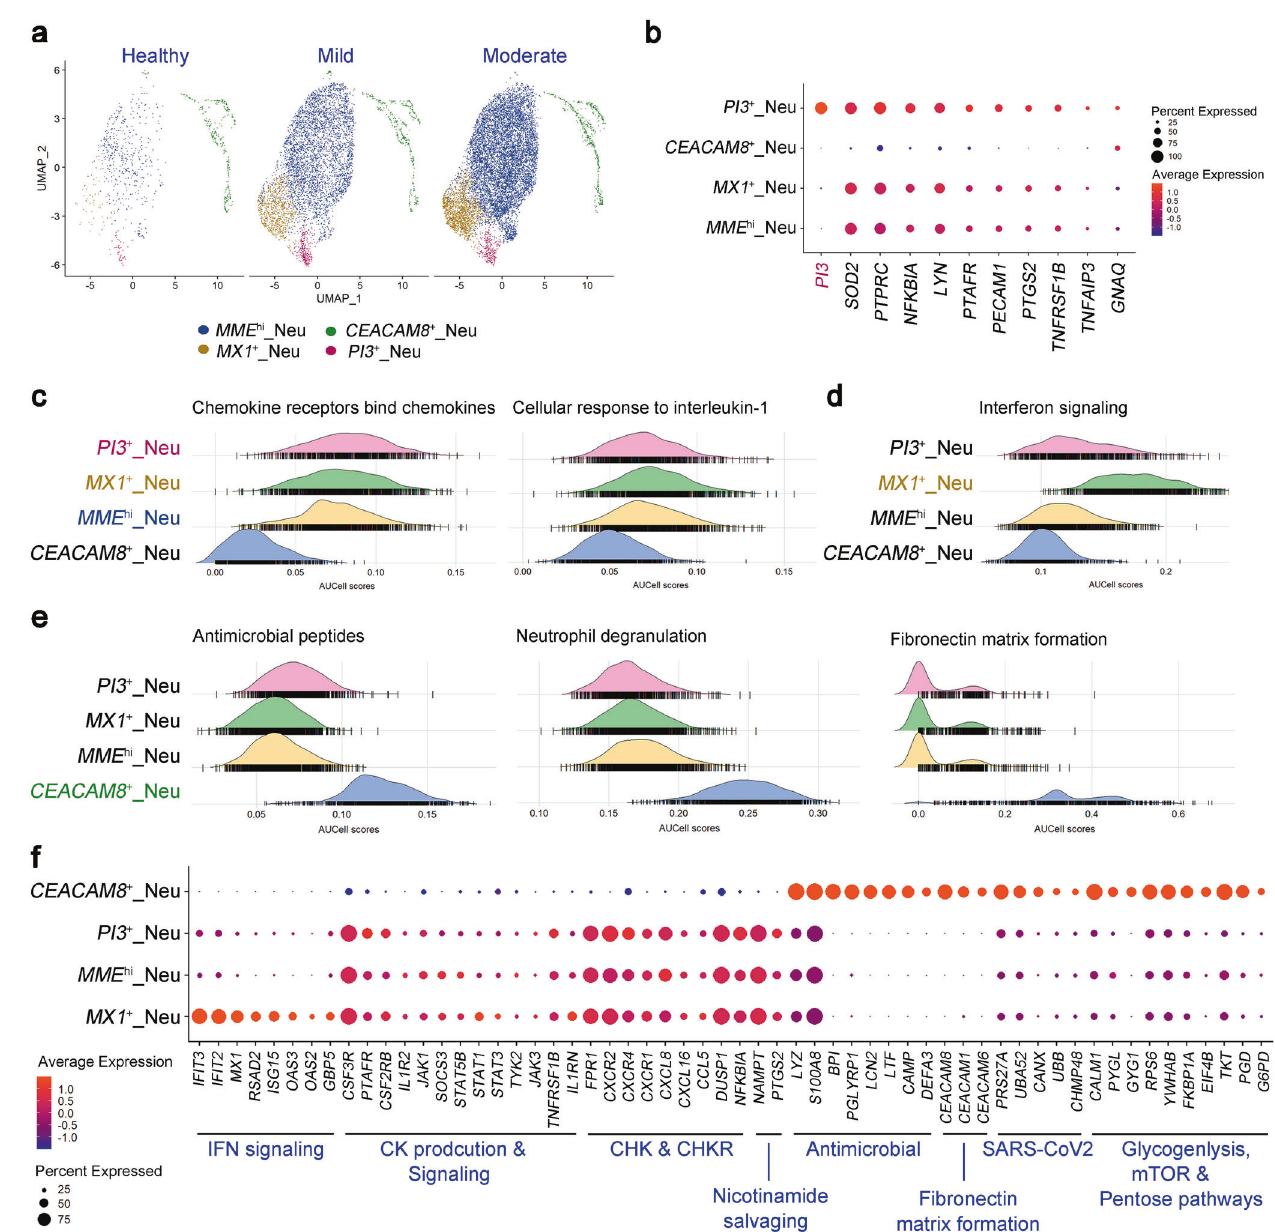
Fig. 4 Biological processes and signaling pathways enriched by the low-density neutrophil (LDN) clusters in Omicron convalescents. a UMAP plots showing the cell clusters of LDNs from convalescents after mild to moderate Omicron infection ( n = 5 for mild and n = 13 for moderate) and healthy donors ( n = 6) using data of WTA scRNA-seq. b Dot plot depicting the differential expression genes by all the LDN clusters. c AUcell plots showing the enrichment on the production and responses to the signaling pathways of in fl ammatory cytokines and chemokines by all the LDN clusters. d AUcell plots showing the enrichment on the cell response to IFN pathway by all the LDN clusters. e AUcell plots showing the enrichment on the processes of innate immune defense and tissue remodeling by all the LDN clusters. f Dot plot depicting the expression of genes enriched on the biological process and signaling pathways described above by the LDN